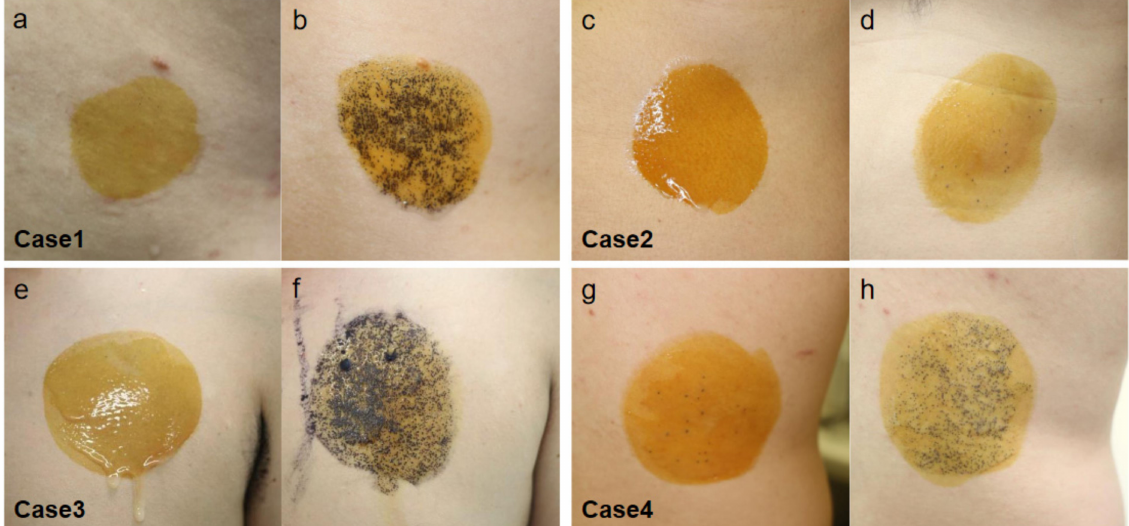
Figure 5. Thermoregulatory sweat test by Minor method using the iodine-starch reaction in our cases. No sweat is observed before treatment in all cases ( a , c , e , g ). Sweating is observed after corticosteroid pulse therapy in Cases 1, 3, and 4 ( b , f , h ), but not in Case 2 ( d